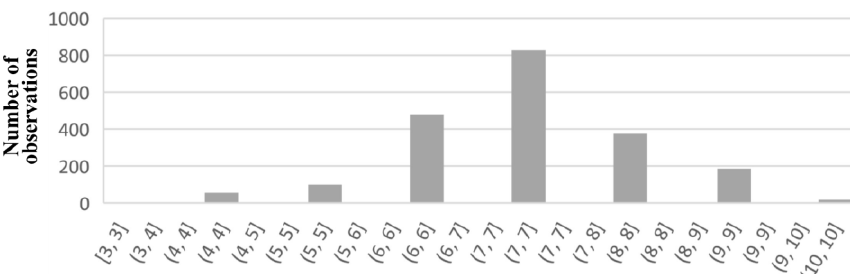
Figure 18. A distribution histogram for the number of available satellites .